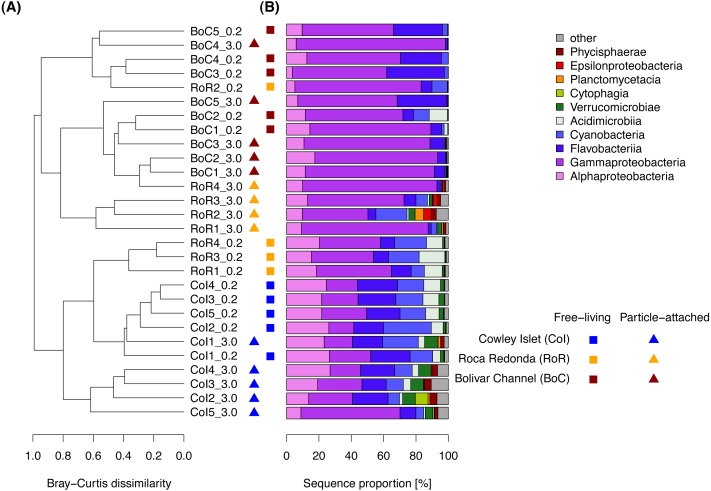
Composition of the free-living and particle-attached bacterial communities in the water column.(A) Cluster diagram based on complete linkage hierarchical clustering of Bray–Curtis dissimilarity coefficients. Sample names specify replicate number at each of the three sampling sites: Cowley Islet (CoI1-5), Roca Redonda (RoR1-4), and Bolivar Channel (BoC1-5), and size fraction: free-living (>0.2μm), particle-attached (>3.0μm). (B) Taxonomic composition of the bacterial communities at class level.